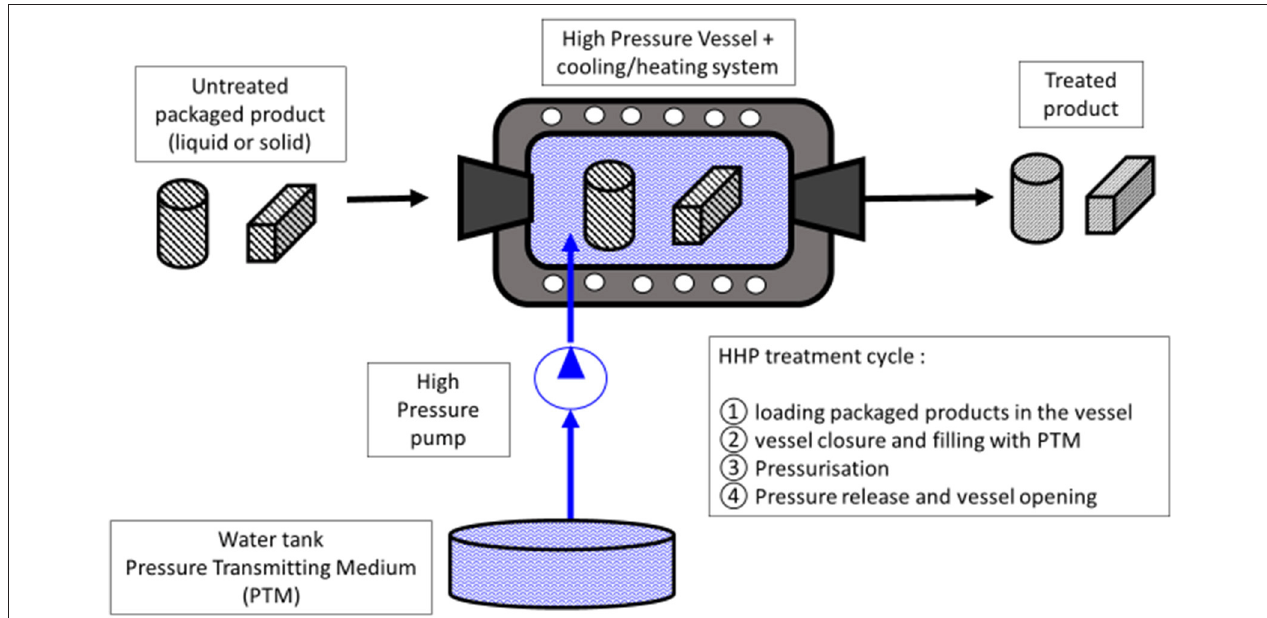
FIGURE 1 | Schematic layout for a High Hydrostatic Pressure (HHP) treatment